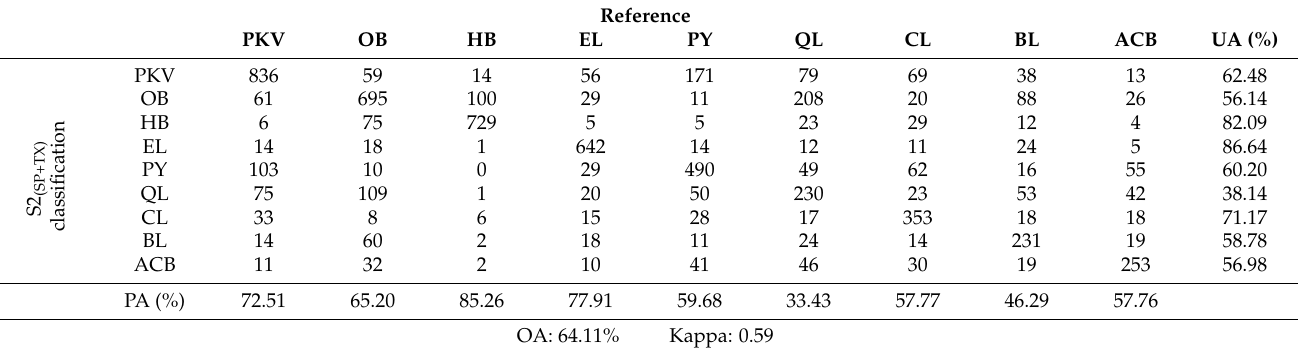
Table A2. Confusion matrix derived using Sentinel-2 spectral and texture features.